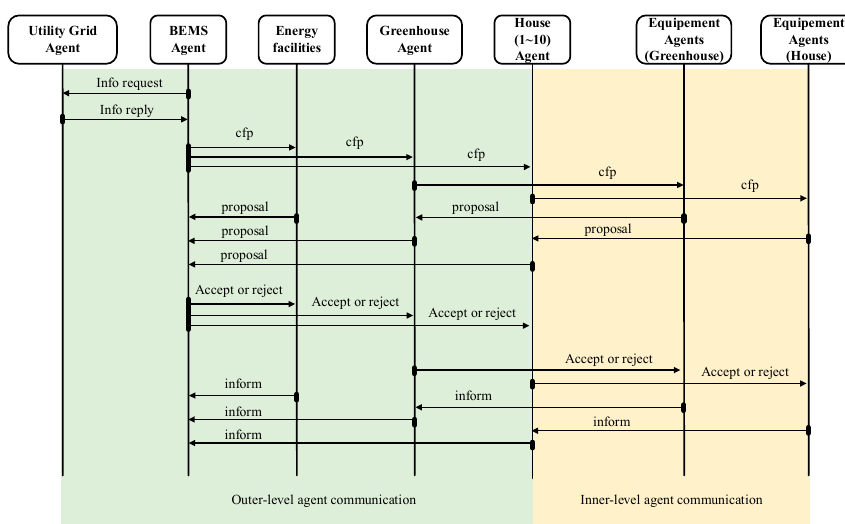
Figure 6. Interaction among different agents.